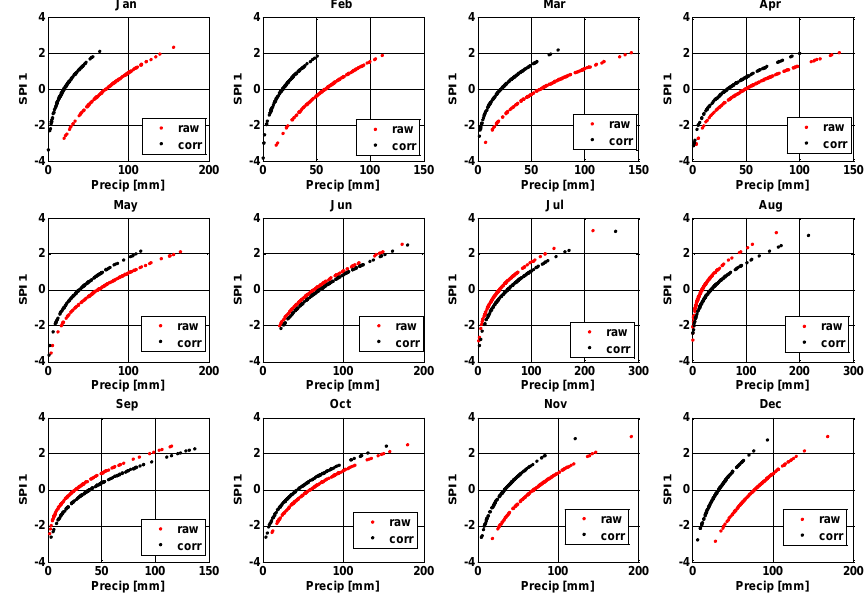
Figure 14. The scatter plots showing relationship between monthly sum of precipitation and estimated SPI 1 values for one grid cell lo- cated close to Białystok (NE Poland) for DMI HIRHAM ARPEGE model. The colour denotes type of data used, red colour – uncorrected precipitation and SPI 1, black corrected